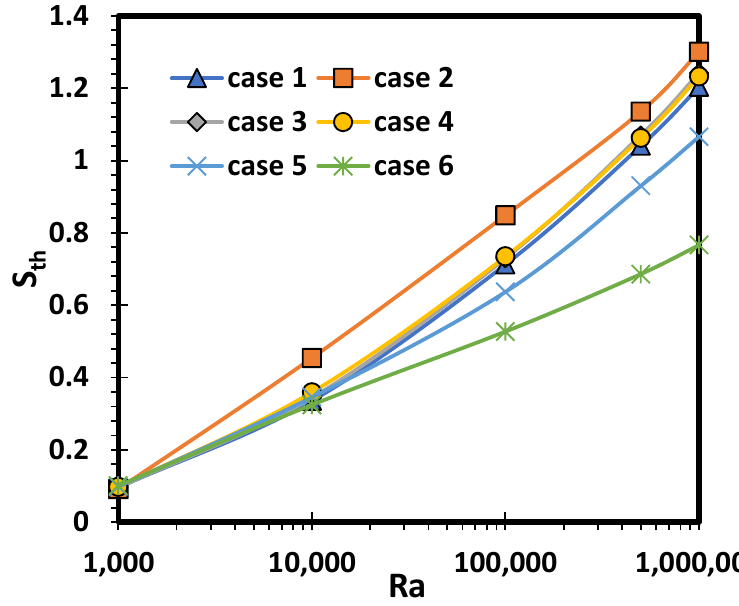
Figure 13. Thermal entropy generation for various heat source positions and different Ra.